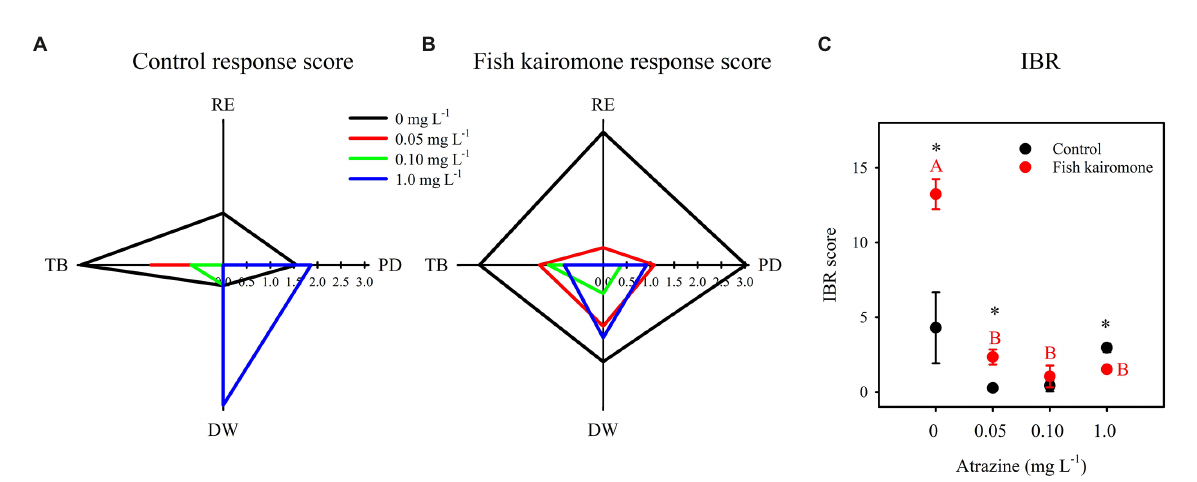
FIGURE 3 The response score (S) and the integrated biomarker response (IBR) of population traits in different treatments. The IBR consists of four indicators: population density at the end of the experiment (PD), total number of resting eggs (RE), total biomass (TB), and average dry weight per individual (DW). Asterisks indicate significant differences between control and kairomone treatments ( * p < 0.05), and uppercase letters indicate differences among the fish kairomone treatment. The error bars indicate standard error. The results of two-way ANOVA are shown in Table